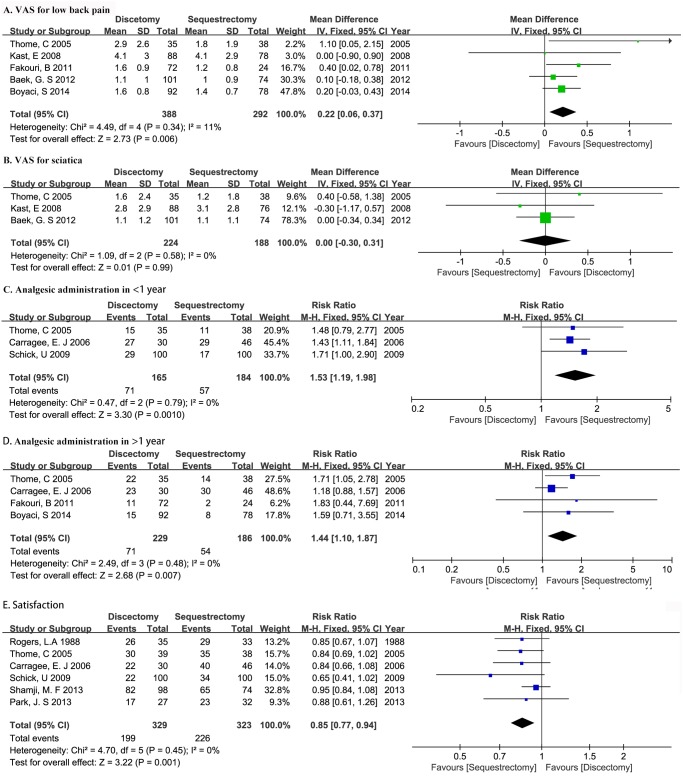
Forest illustrating plot post-operative VAS for low back pain (A), post-operative VAS for sciatica (B), analgesic administration in less than 1 year post operation(C), analgesic administration in more than 1 year post operation(D), and satisfaction rate (E) of meta-analysis comparing discectomy with sequestrectomy.